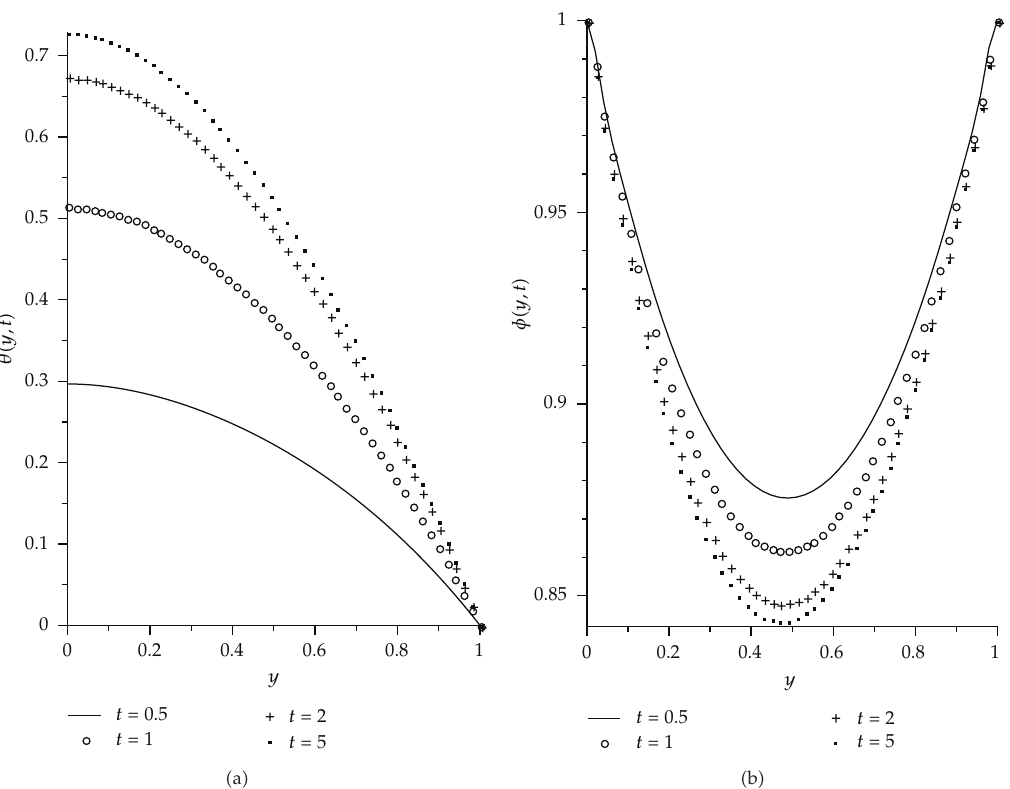
Figure 3: Temperature and oxygen concentration profiles for m (cid:8) 0 . 5, n (cid:8) 2, α (cid:8) β (cid:8) λ (cid:8) 1 , θ w (cid:8) 0 , ε (cid:8) 0 .